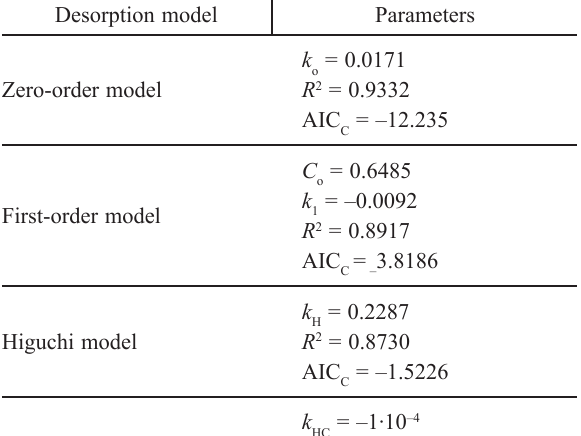
Table 6 – Values of the desorption parameters for the vita- min E/zeolite system Desorption model